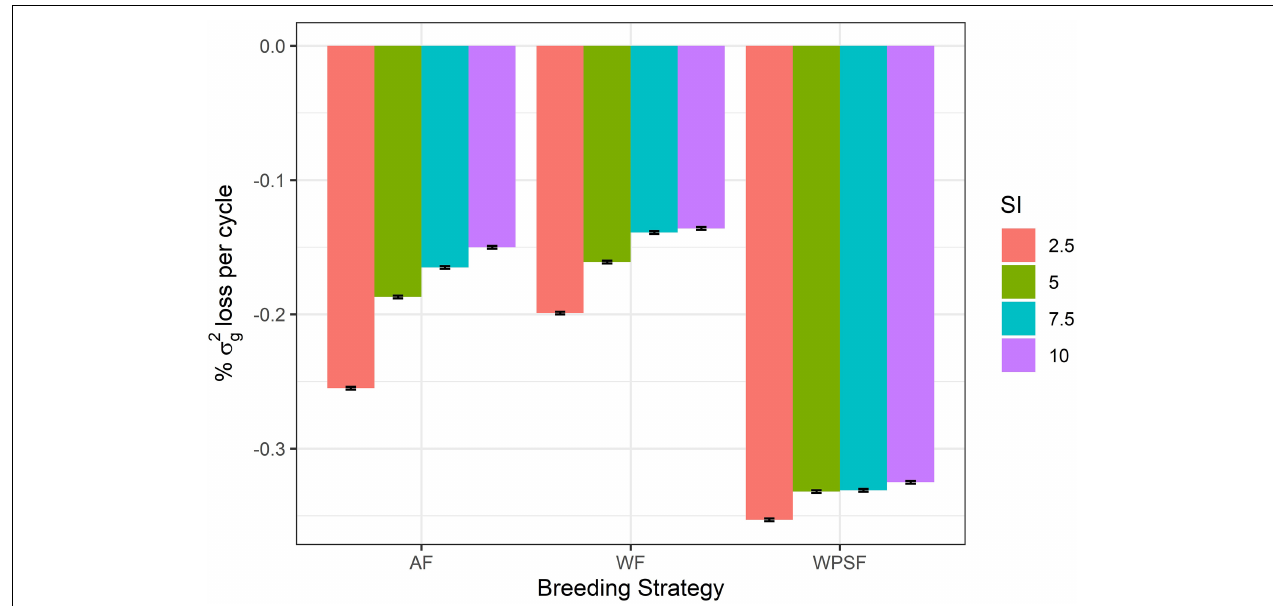
FIGURE 5 | Genetic drift per cycle under random selection across family (AF), within pre-selected families (WPSF), or within family (WF) in different selection intensities (SI).